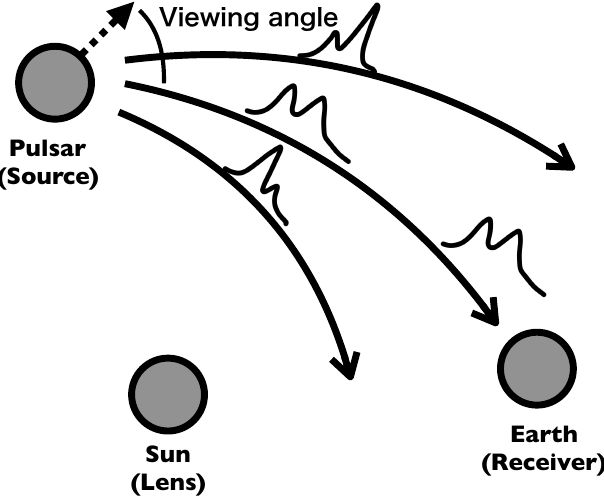
Figure 3. Observable α in Equation (7): In this schematic figure, the lens, receiver, and source are respectively the Sun, the Earth, and a pulsar that periodically radiates radio signals in a specific anistropic manner. From the pulse profile, we can determine the radiation direction at the source. By using the ephemeris, we know the relative positions of the Sun, Earth, and the pulsar. Hence, we can determine φ RS and Ψ S . By observing the pulsar, we can measure Ψ R . In principle, therefore, we can determine Ψ R − Ψ S + φ RS from these astronomical